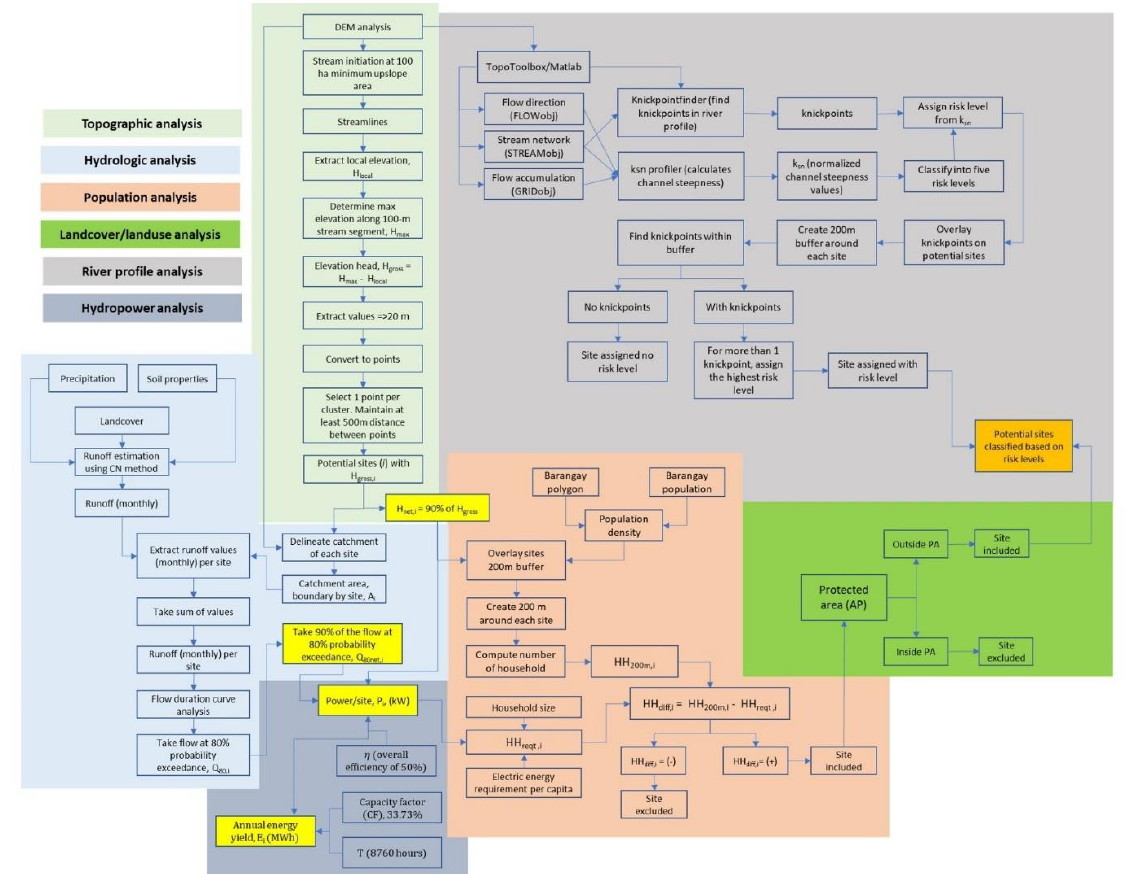
Figure A1. A detailed flow of analysis for the study.